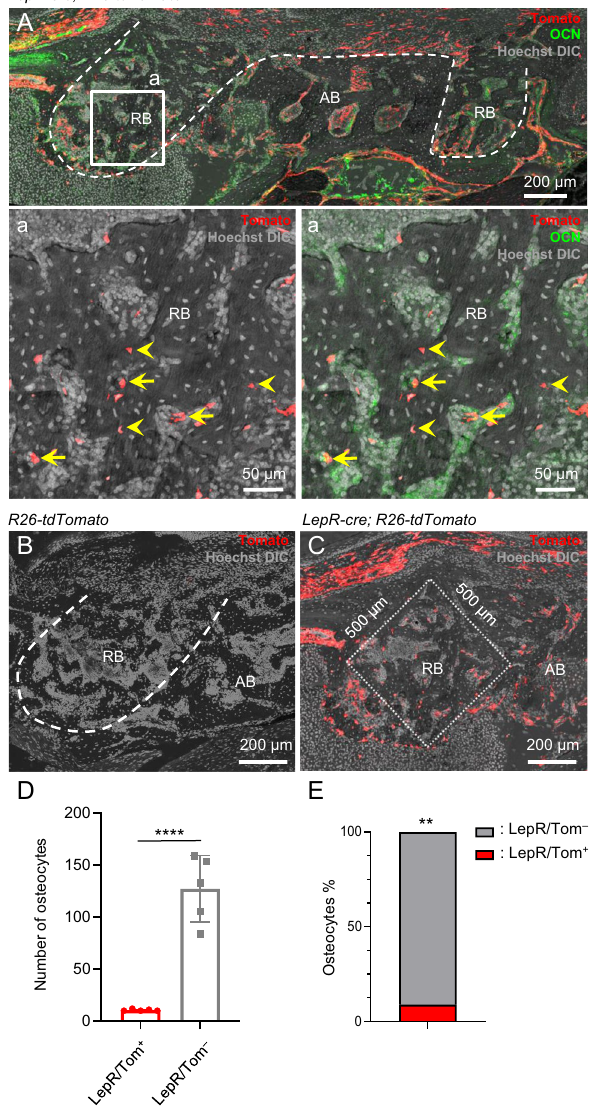
Figure 3. LepR/Tom + PDL cells contribute as some of the osteocytes in regenerative bone tissue of the extraction socket. (A–E) Lineage tracing analysis of LepR/Tom + cells in regenerative bone (RB) tissue of extraction socket. (A, B) Representative confocal images (Z stack) in thick sections of regenerated bone in the socket of maxillary first molars after 2 weeks post tooth extraction in 4-week-old LepR-cre ; R26-tdTomato mice stained with anti-OCN antibody ( A , n = 5) or in 4-week-old R26-tdTomato control mice ( B , n = 3). Scale bar = 200 μm. Lower panels represent the magnified views of the boxed areas; scale bar = 50 μm. Arrows: LepR/ Tom + OCN + osteoblasts, arrowheads: LepR/Tom + osteocytes. Dotted lines indicate the border of the extraction socket. Nuclei were visualized using Hoechst. ( C–E ) Quantification of LepR/Tom + and LepR/Tom − osteocytes in RB tissue of the extraction socket. ( C ) Representative quantification area in RB (0.25 μm 2 ). Scale bar = 200 μm. Nuclei were visualized using Hoechst. ( D ) Absolute number of osteocytes in RB (Two-tailed Student’s t -test). ( E ) Frequency of LepR/Tom + and LepR/Tom − osteocytes in RB (two-tailed Mann–Whitney U -test); n = 5. ** p < 0.01, **** p < 0.0001. Data are represented as mean ± standard deviation (SD). OCN: osteocalcin, RB: regenerated bone, AB: alveolar bone, DIC: differential interference